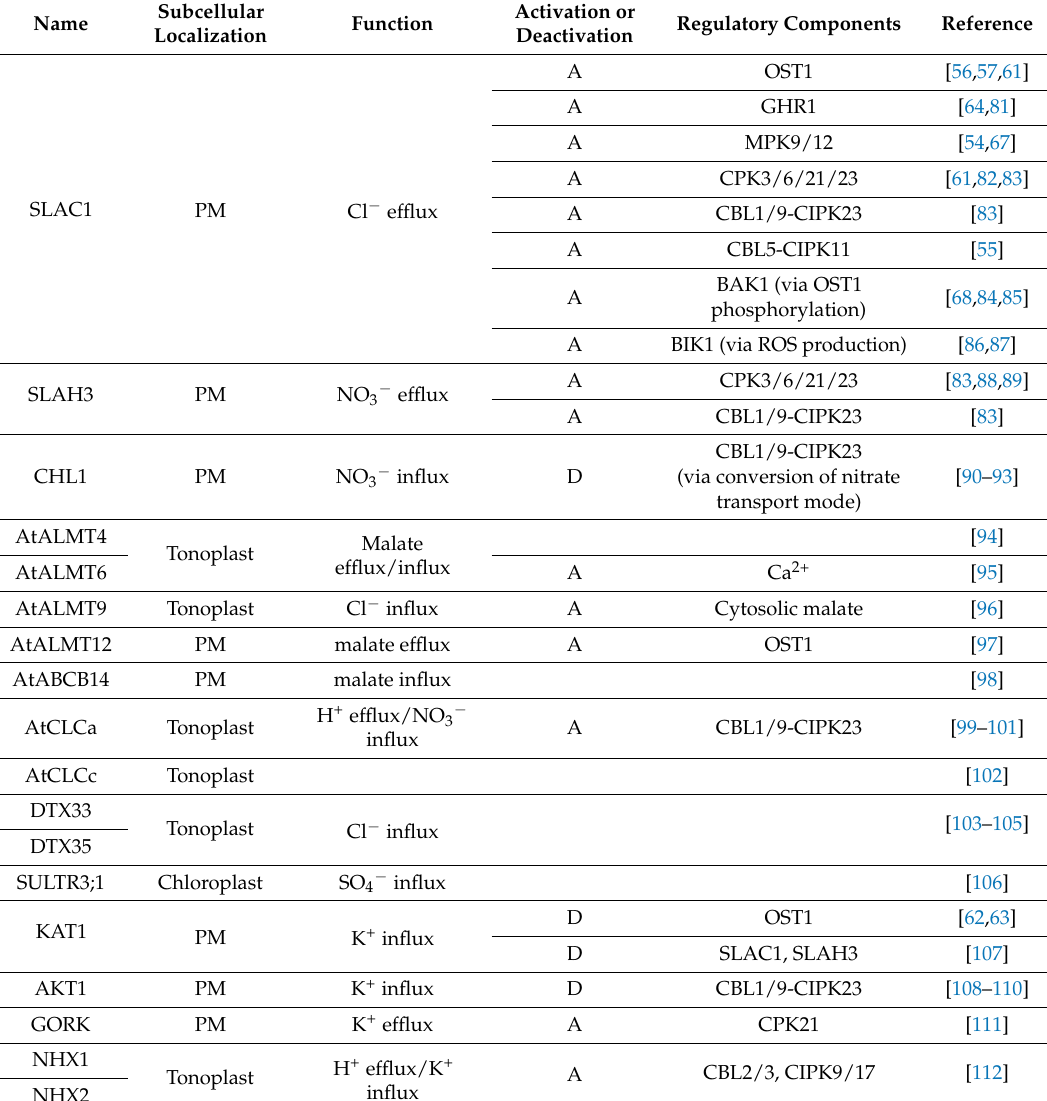
Table 1. List of guard cell expressed ion channels/transporters and their regulator